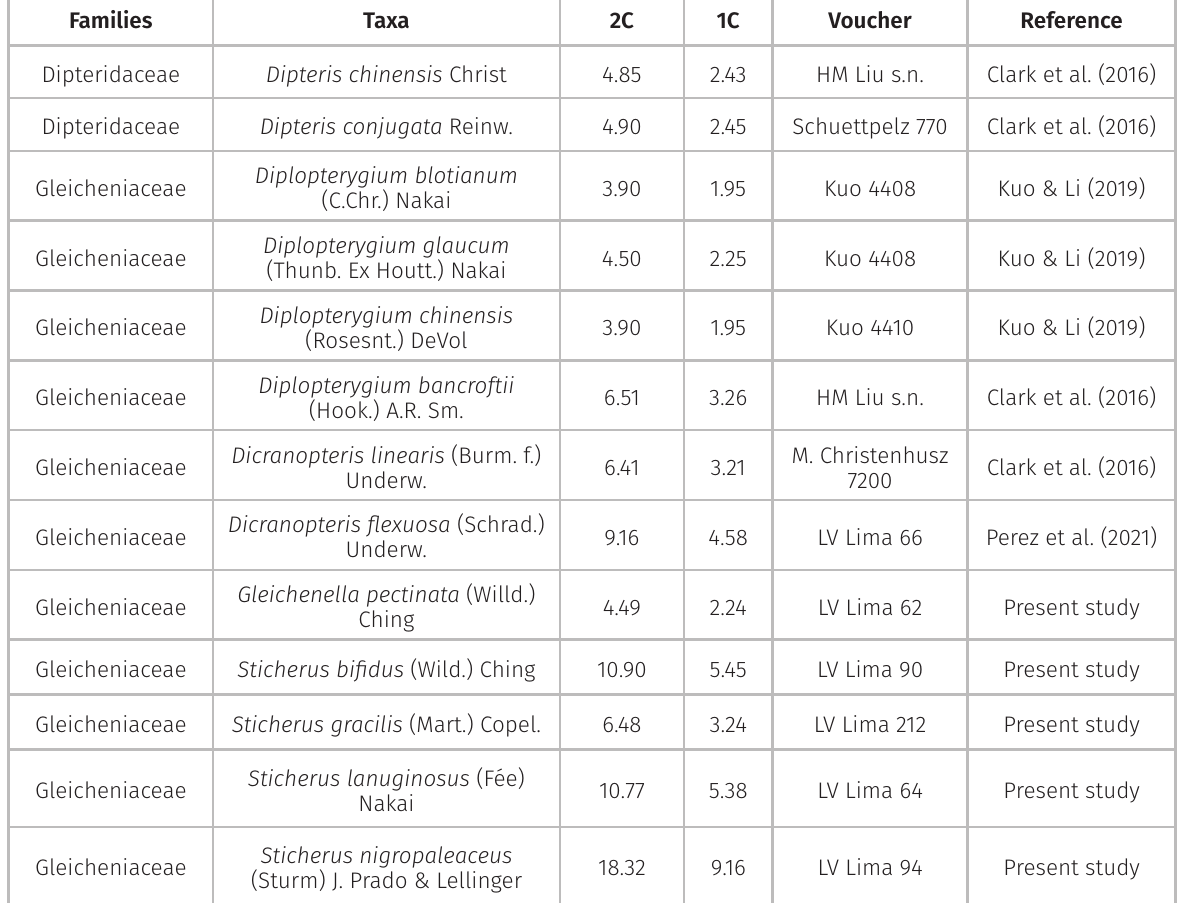
Table II. Gleicheniales species with C-values reports. Family names follow PPG I (2016).